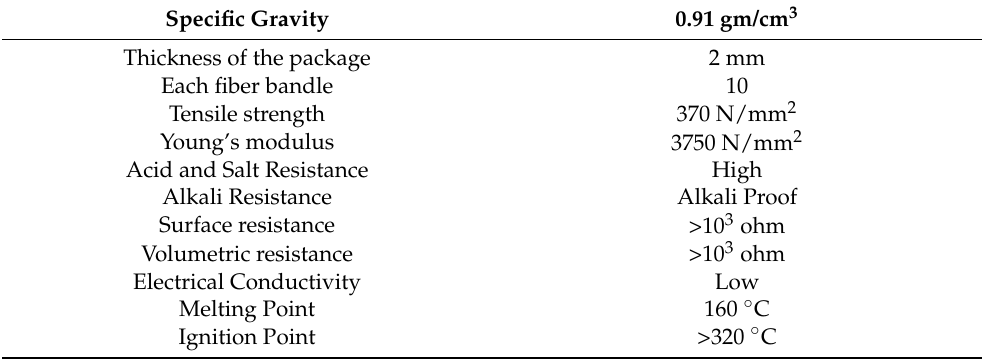
Table 7. Physical and mechanical properties of polypropylene fibers.